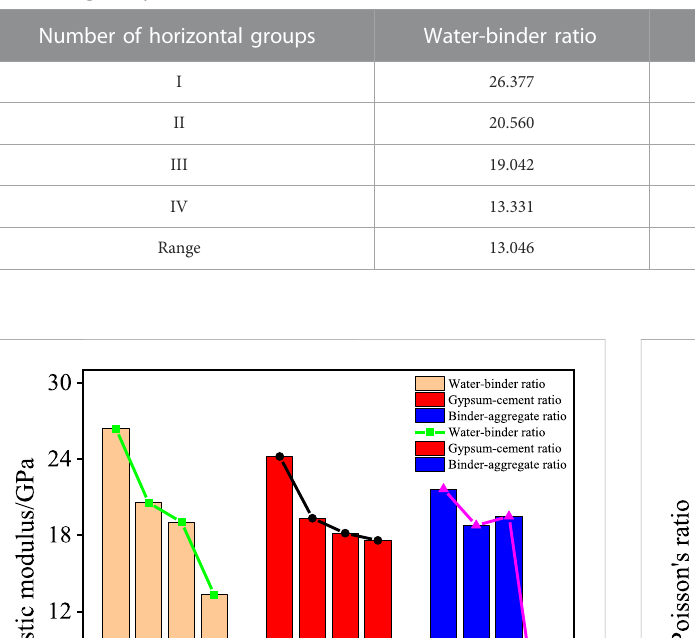
TABLE 7 Range analysis of elastic modulus.